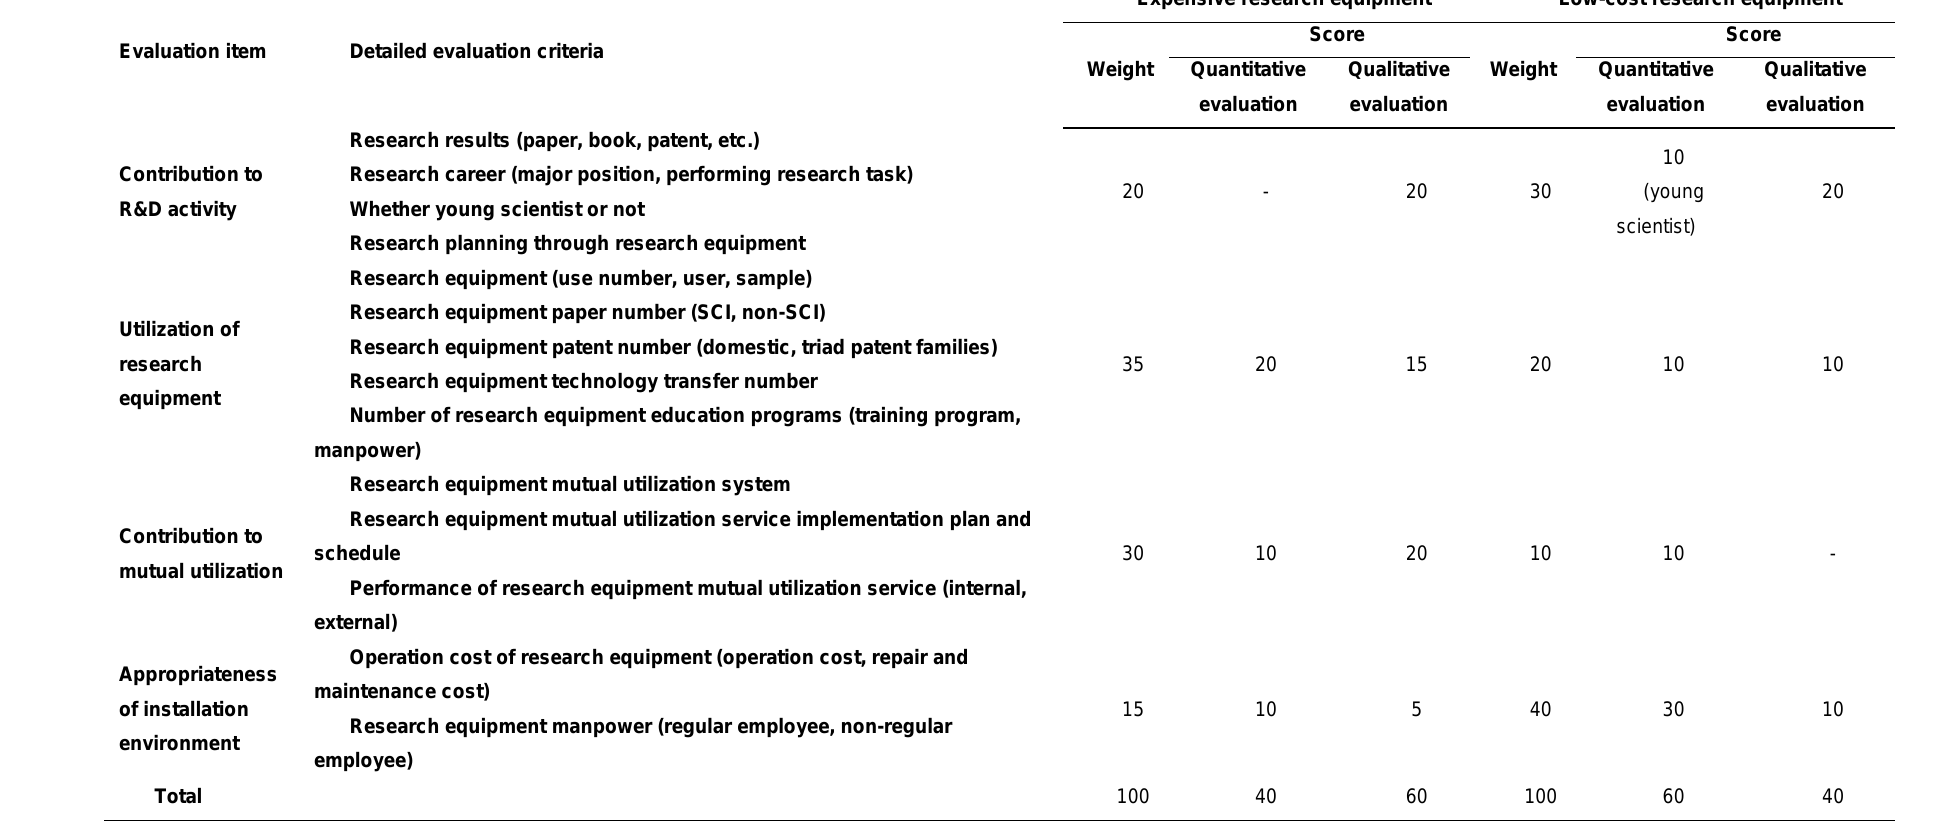
Table 18. Evaluation criteria for relocation of research equipment